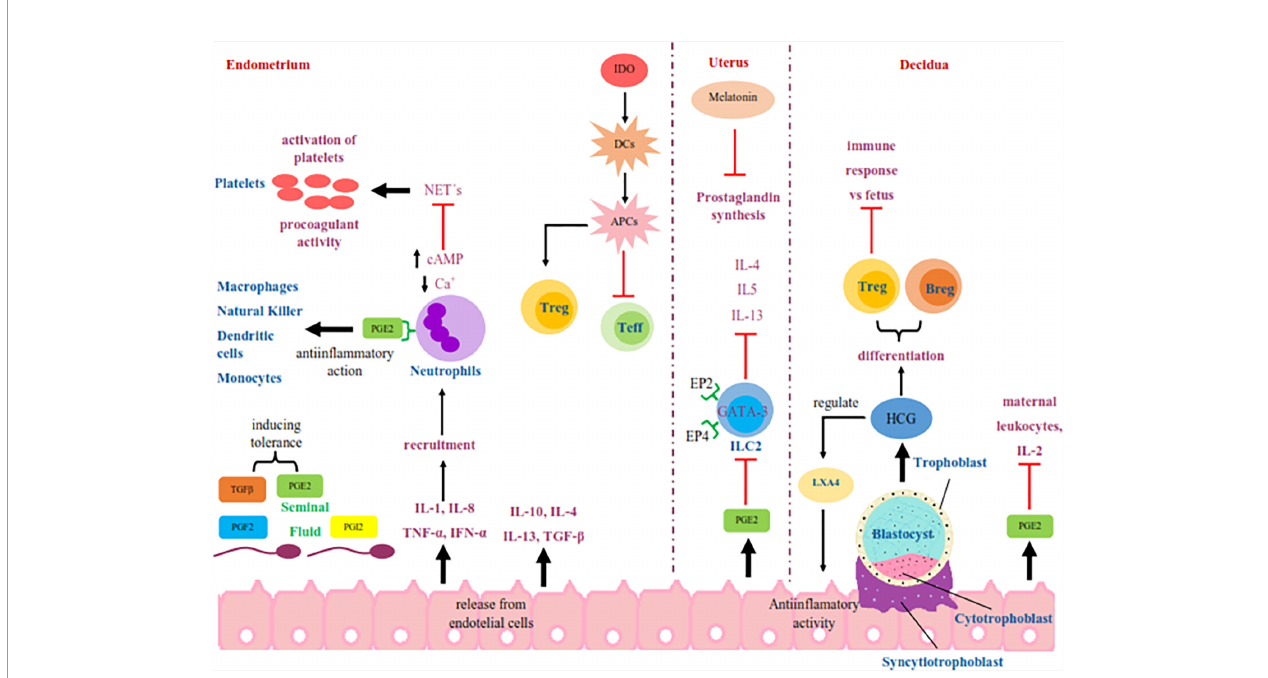
FIGURE 1 | Schematic representation of the signaling in the maternal immune response that begins with the deposition of seminal fl uid in the female reproductive tract during intercourse. The seminal fl uid start an immune signaling pathways mediated by PGE2 and PGI2 in the functions of endothelial cells, platelets, neutrophils, ILC2, lymphocytes, macrophages, natural killer, dendritic cells and monocytes during oocyte fertilization and early implantation. In addition, the molecules released by these cells like interleukins, HCG, IDO, and LXA4 have a fundamental role in this tolerance process. PGE2, prostaglandin E2; PG12, prostaglandin I2; PGF2, prostaglandin F2; TGF b , transforming growth factor beta; IL-1, interleukin-1; IL-2, interleukin-2; IL-4, interleukin-4; IL-5, interleukin-5; IL-8, interleukin-8; IL-10, interleukin-10; IL-13, interleukin-13; TNF- a , tumor necrosis factor-alpha; INF- a , interfero ́ n alpha; Ca+, calcio; cAMP, cyclic adenosine monophosphate; NET´s, neutrophil extracellular traps; IDO, indoleamine-2,3-dioxygenase; DCs, mature dendritic cells; APCs, tolerogenic antigen presenting cells; Treg, regulatory T cells; Teff, effector T cells; GATA-3, GATA-3 transcription factor; EP2, prostaglandin E2 receptor 2; EP4, prostaglandin E2 receptor 4; ILC2, group 2 innate lymphoid cells; Breg, regulatory B cells; HCG, human chorionic gonadotropin; LXA4, Lipoxin